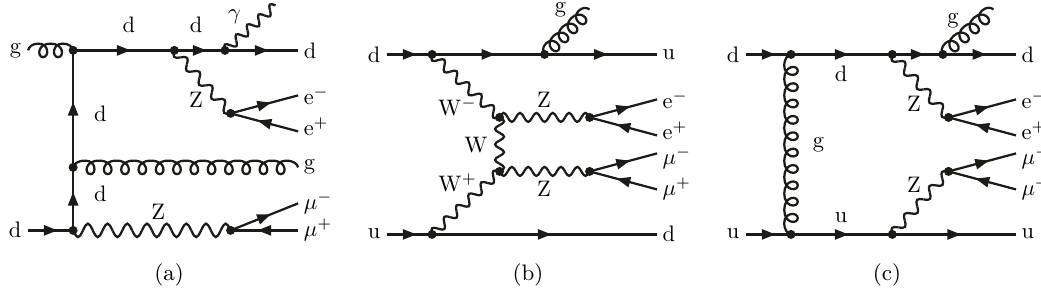
Figure 2 . Examples of real tree-level Feynman diagrams: photon emission (left) and gluon emission off LO EW (middle) and QCD diagrams (right).